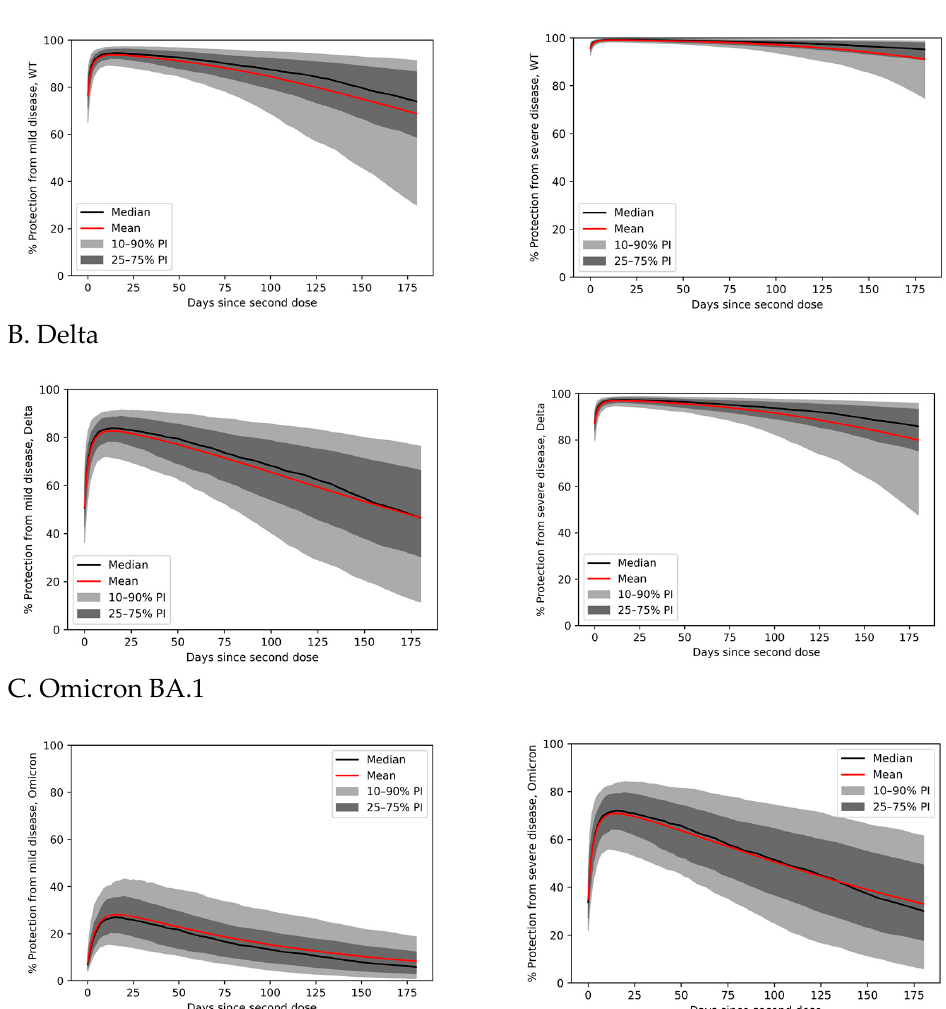
Figure 4. Protection from mild (left) and severe (right) COVID-19 by percentile over time since the second dose of the two-dose Moderna vaccination primary series. Protection is assessed for ( A ) wild type, ( B ) delta, and ( C ) omicron BA.1.